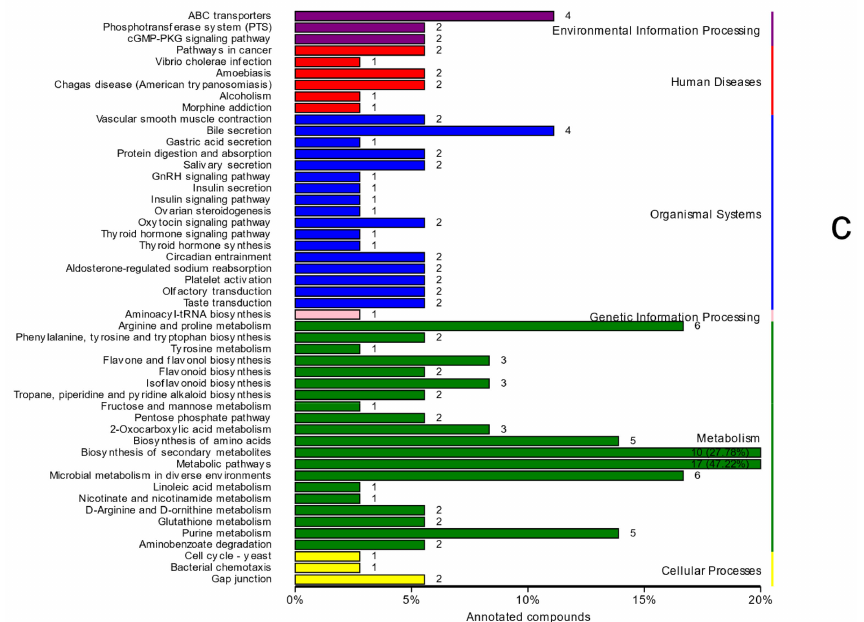
Figure 7. Classification diagram of KEGG, a differential metabolite. ( a ) CK vs. A; ( b ) CK vs. B; ( c ) A vs. B. Note: The ordinate is the name of the KEGG metabolic pathway, and the abscissa refers to the number of metabolites that were annotated on the pathway as a proportion of the total number of metabolites that were